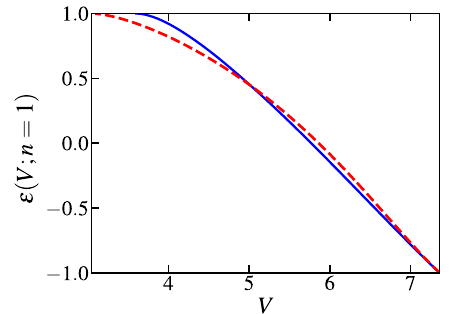
Fig. 1 Dependence of the ground ( n = 1) bound energy level ε on the depth of the well V at (cid:2) = − 1 and R = 1 / 2. The solid line corresponds to the numerical solution of the Eq. (15), the dashed line — to the approximation (16)